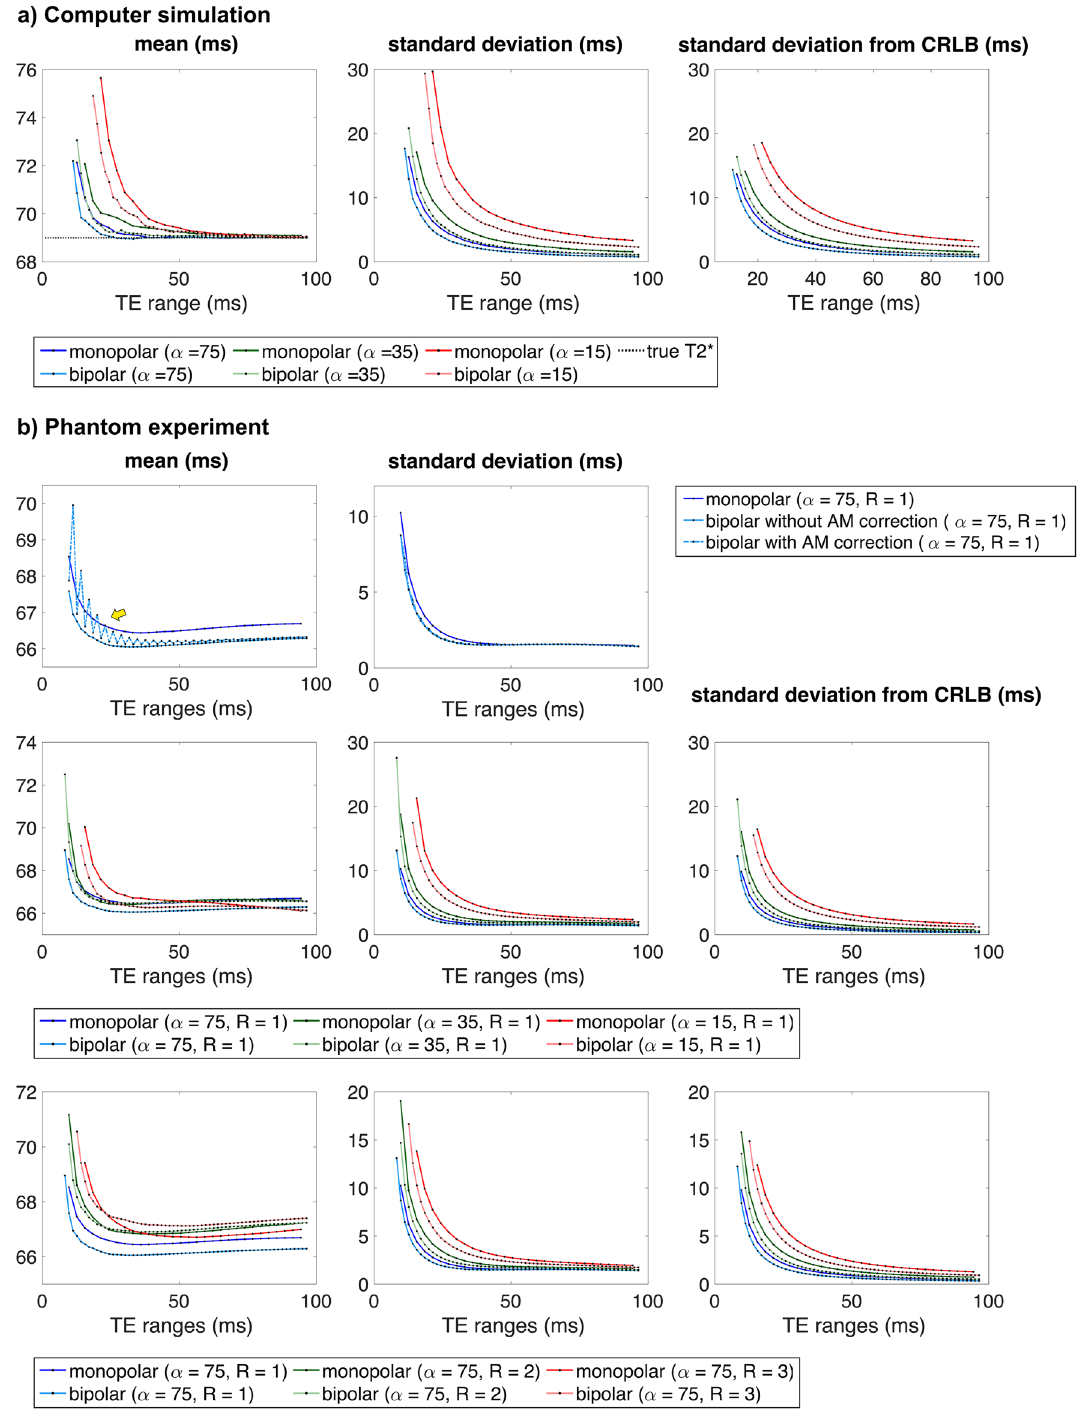
Figure 3. Plots of the mean and standard deviations as a function of the TE range. The mean and standard deviations were measured in ROI 3. Imaging parameters: BW/px = 801, ∆TE = 2.92 ms for monopolar and 1.47 ms for bipolar, TR = 1200 ms. ( a ) Computer simulation results. ( b ) Phantom experiments results. The first row shows the effects of amplitude modulation. In the case of bipolar readout, the fluctuations in the mean value can be removed by an amplitude modulation correction. In the second and third rows, the changes in mean and standard deviations are displayed with respect to the α and R. As the SNR decreases (i.e., as the α decreases and R increases), the mean and standard deviation tend to